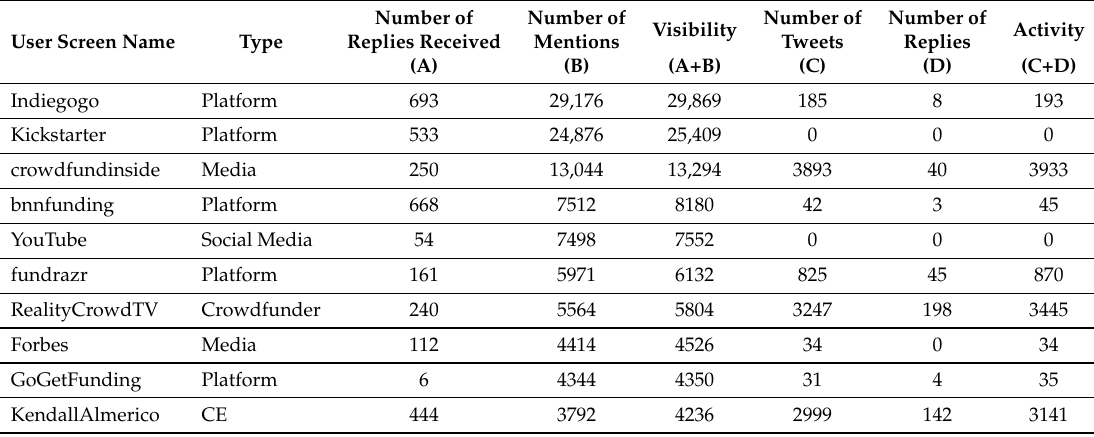
Table 3. Top 10 Most Visible